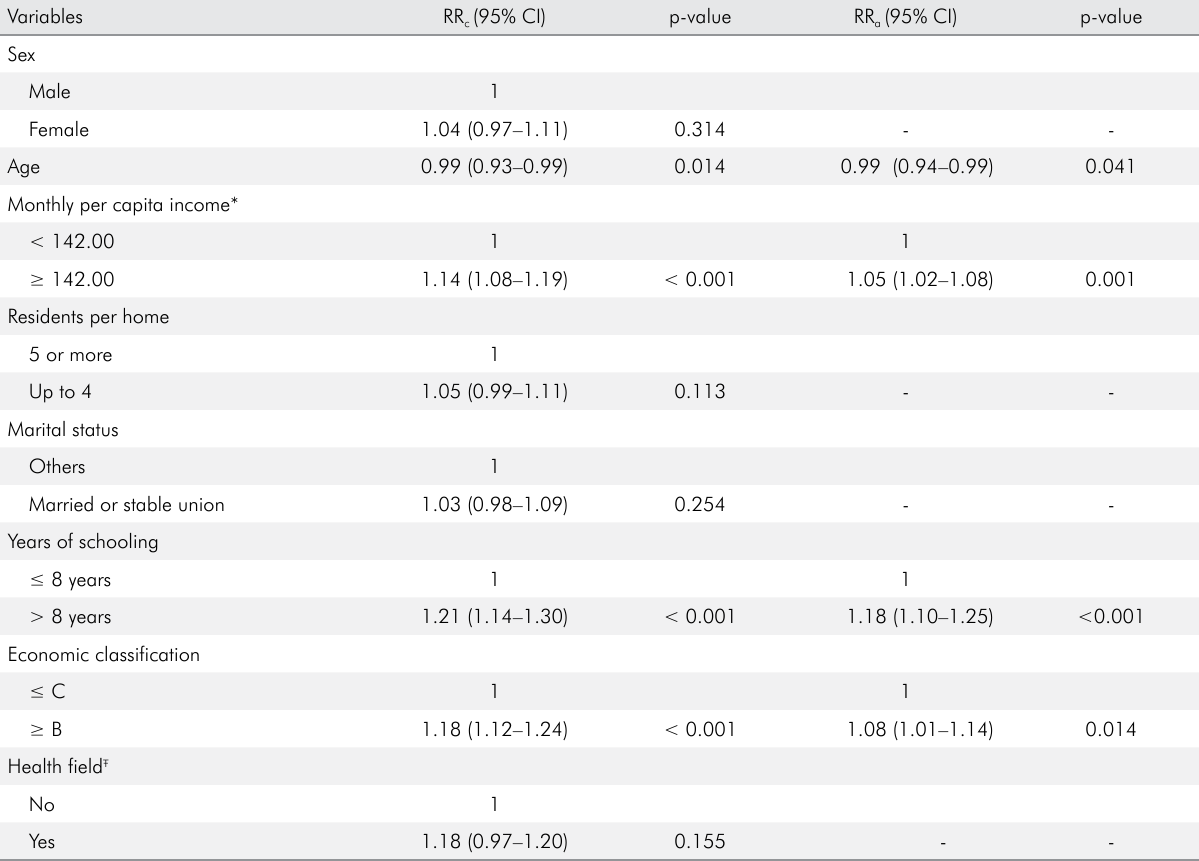
Table 3. Univariate and Poisson regression multivariate model for association between HeLD-14 score and the variables of interest (Curitiba, Brazil,